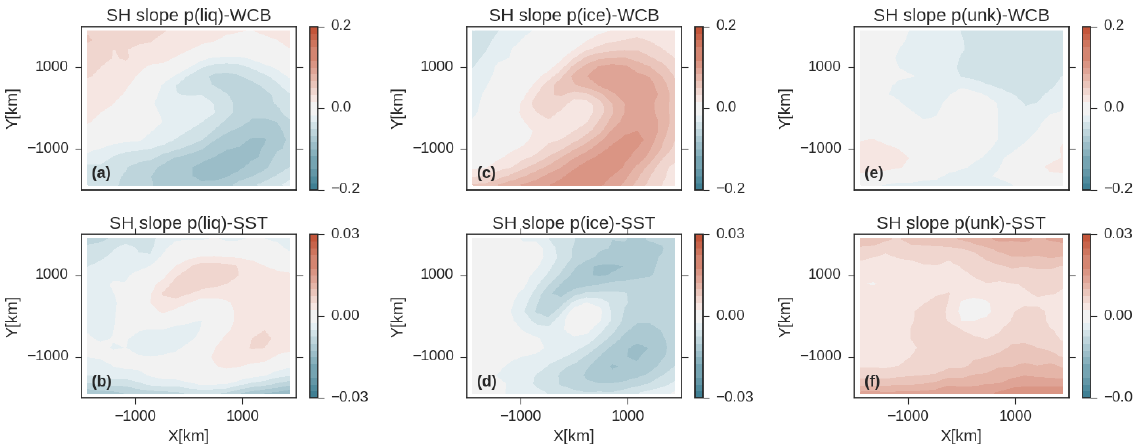
Figure 12. As in Fig. 11, but for the